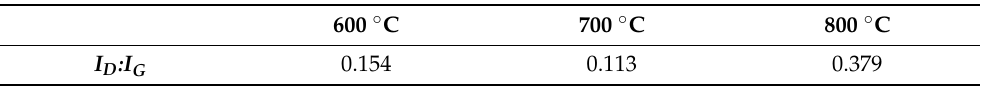
Table 1. The ratio of the integrated value of the D-band and the integrated value of the G-band of carbon fiber at different deposition temperatures: I D :I G